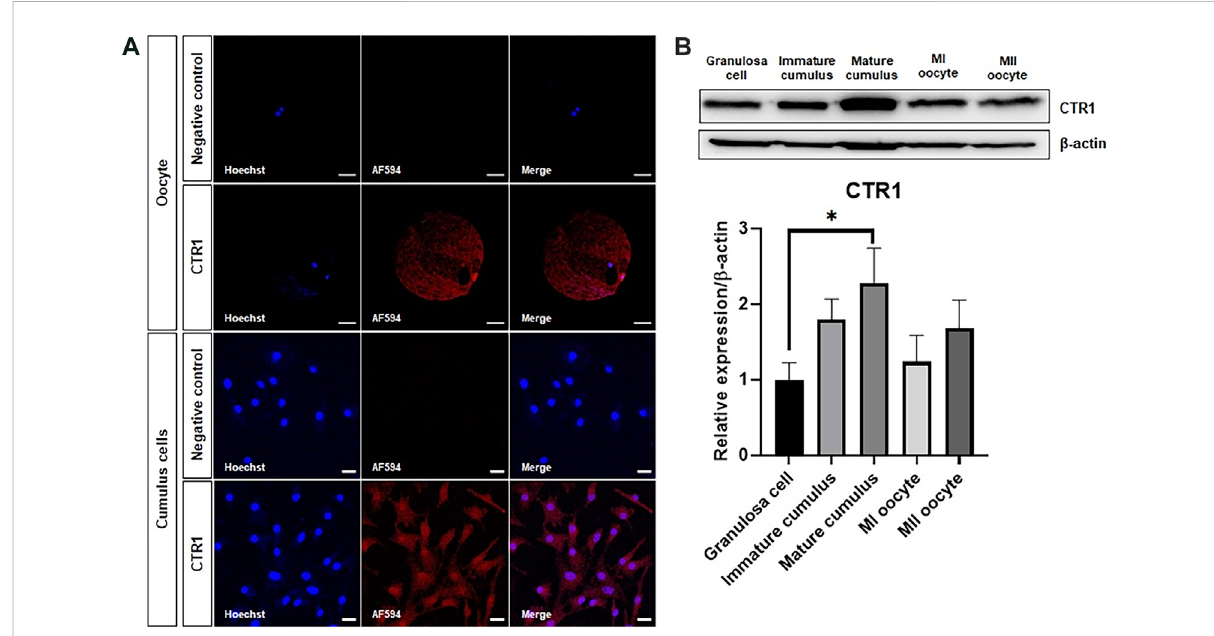
FIGURE 1 Identi fi cation of the copper transporter CTR1 in porcine oocytes and cumulus cells. (A) Immuno fl uorescence indicating the localization of the CTR1 in meiosis II stage-oocytes and mature cumulus cells. Scale bar = 50 and 20 μ m, respectively. (B) A representative western blot image and relativedensitometricbargraphoftheCTR1expressioningranulosa cells,immaturecumulus,mature cumulus,meiosisI(MI)oocytes,andmeiosisII (MII) oocytes. An asterisk indicates statistical signi fi cance (* p < 0.05).